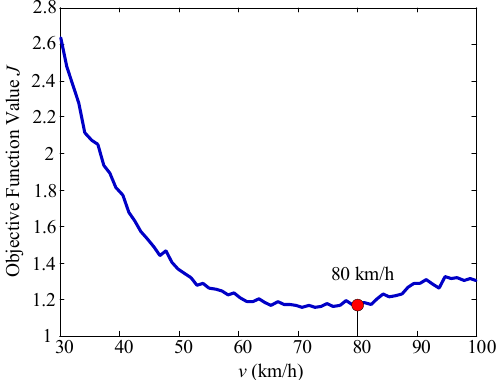
Figure 9. The objective function value under consecutive speed control humps.